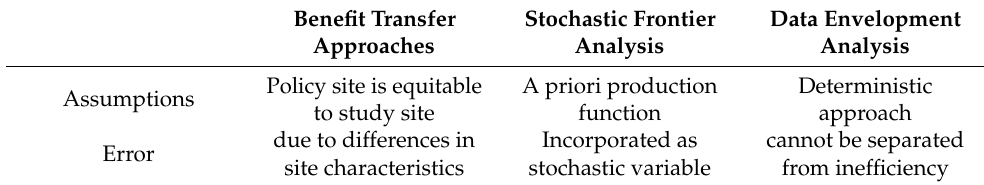
Table 1. Advantages and disadvantages of benefit transfer approaches, stochastic frontier analysis, and data envelopment analysis for assessing the value of ecosystem services in natural stormwater treatment systems. Adapted from [168].